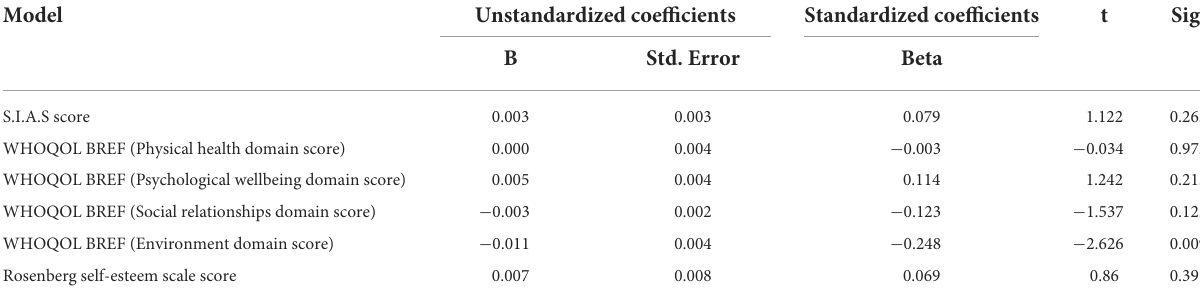
TABLE 3 Regression analysis for relationship between variables and smartphone addiction.